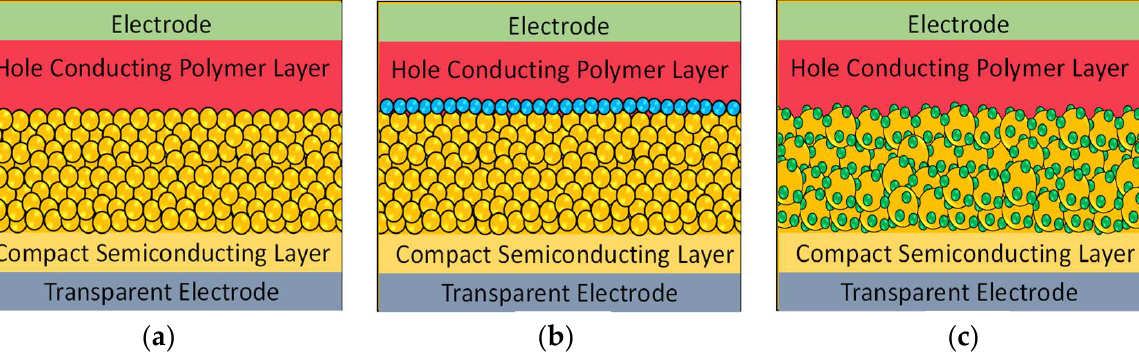
Figure 2. A proposed model of a device structure for nanoparticle based TiO 2 /P3HT hybrid solar cells and their interface modification. Depicted ( a ). TiO 2 nanoparticle based mesoporous structure and P3HT nanocomposite without any interface modification, ( b ). TiO 2 nanoparticle based mesoporous and P3HT nanocomposite structure with insulating layers, and ( c ). TiO 2 nanoparticle based mesoporous and P3HT nanocomposite structure with small molecule interface modifiers.